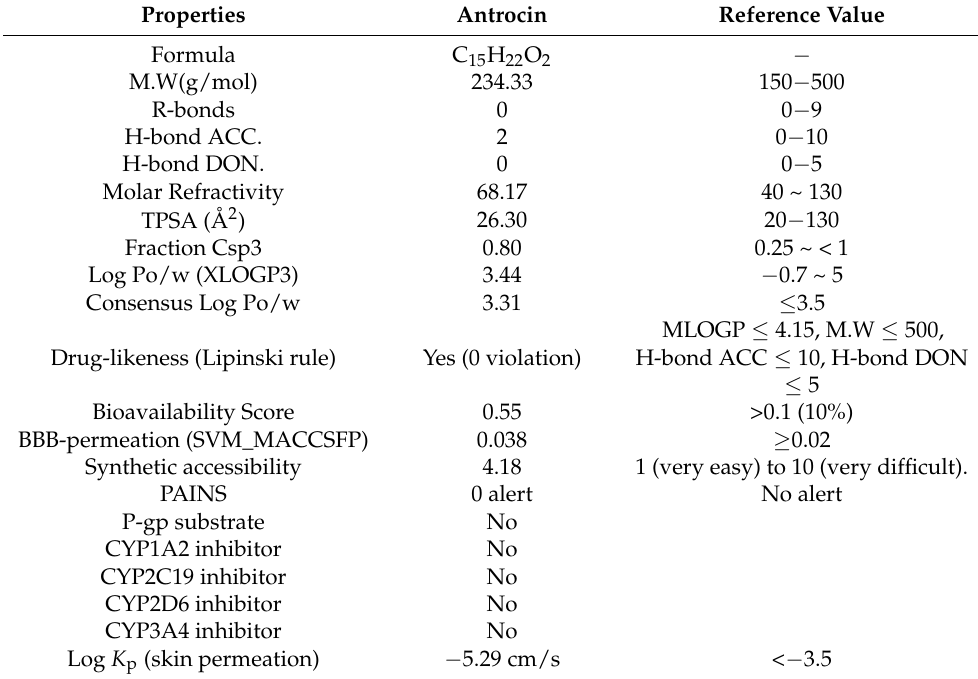
Table 5. Drug-like and properties of antrocin.